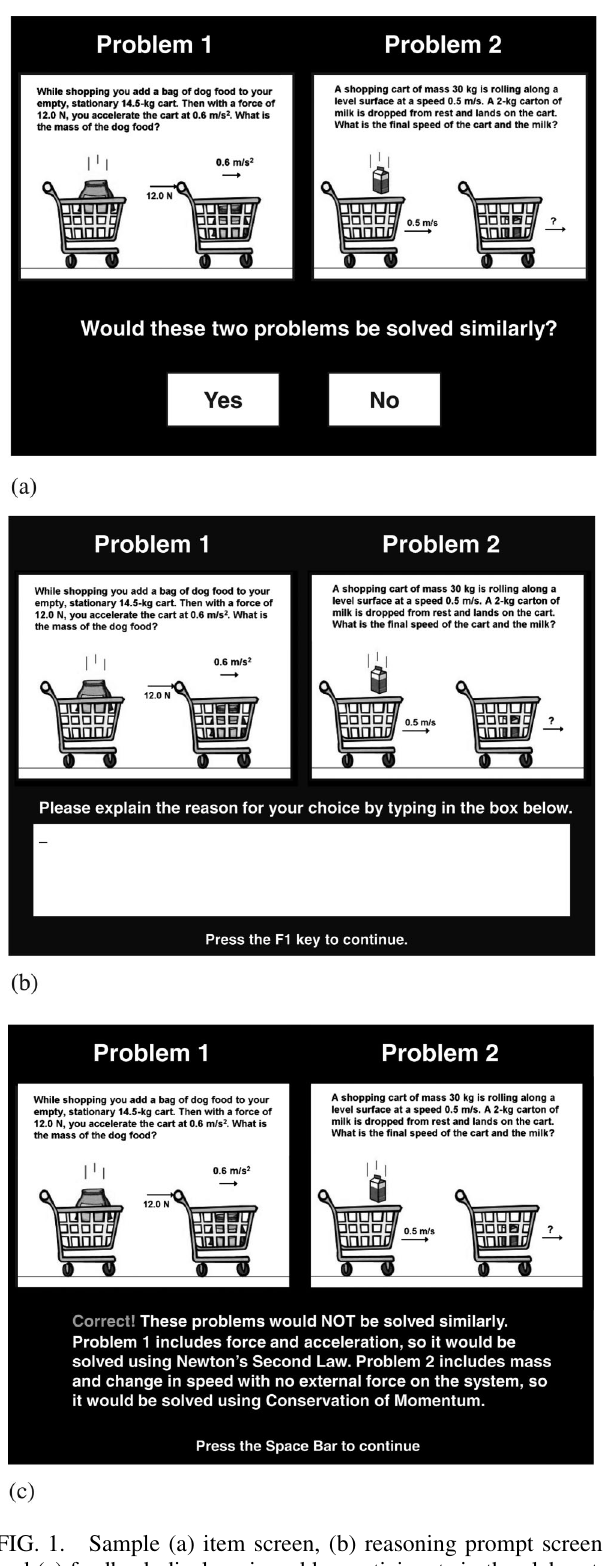
FIG. 1. Sample (a) item screen, (b) reasoning prompt screen, and (c) feedback display viewed by participants in the elaborate condition. Participants in the sparse condition viewed only the first line of the feedback. These problems match on surface features (shopping cart) but would be solved using different physics